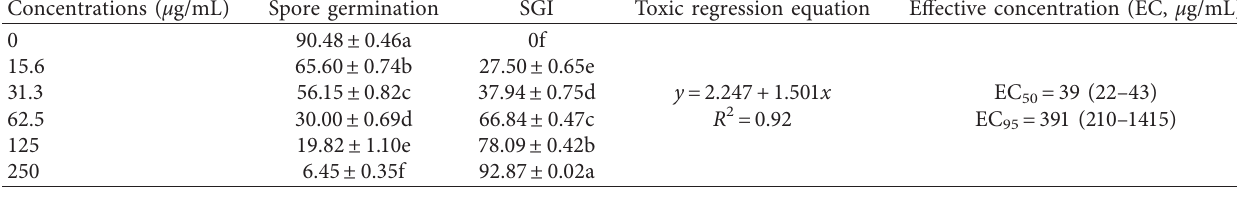
Table 3: Effect of different 4-methoxy CA concentrations on germination of spores of P. digitatum after incubation at 27 ± 1 ° C for 12h. Concentrations ( μ g/mL) Spore germination SGI Toxic regression equation Effective concentration (EC, μ g/mL)